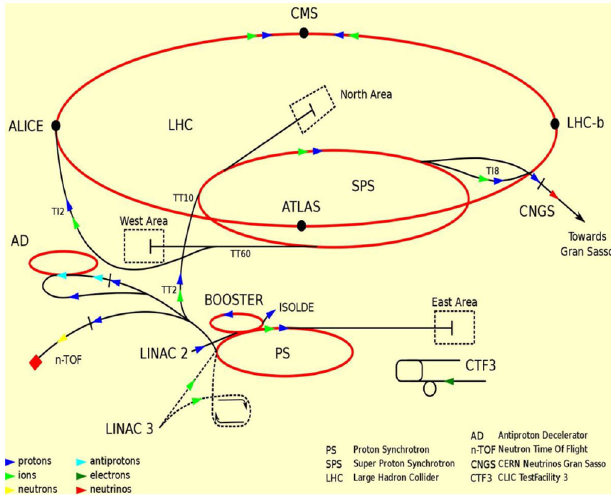
FIG. 2. Large Hadron Collider injector complex, with the SPS as preinjector, and the CERN proton synchrotron complex to prepare the beams for injection into the SPS.